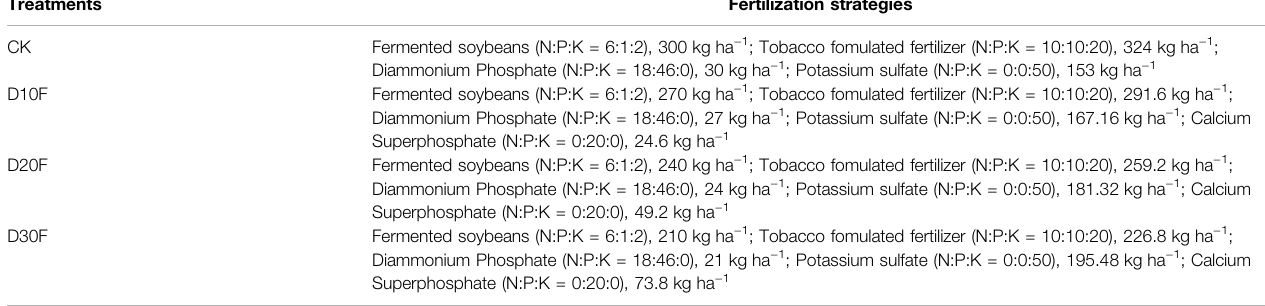
TABLE 1 | Fertilization strategies of fi eld experiments.